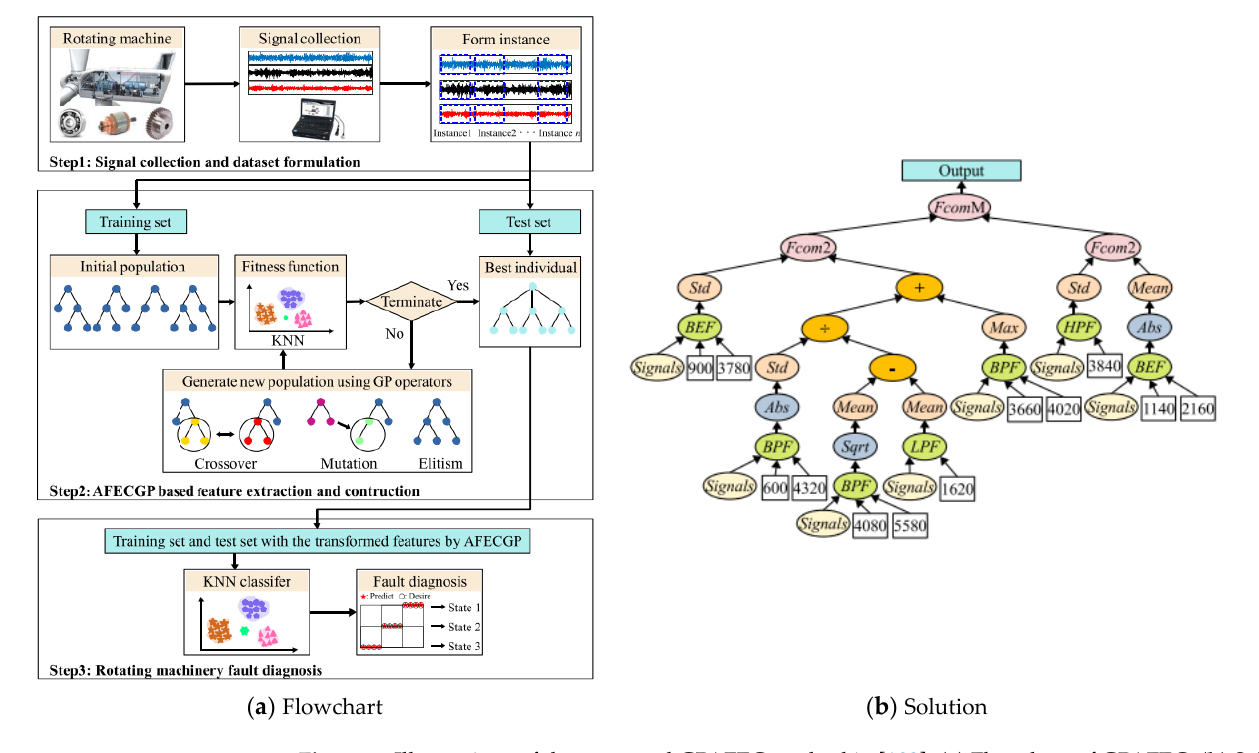
Figure 6. Illustrations of the proposed GPAFEC method in [183]. ( a ) Flowchart of GPAFEC, ( b ) Solution evolved by GP.